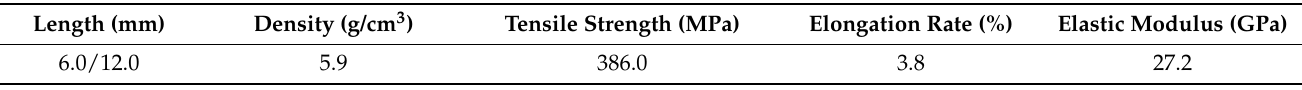
Table 1. Key characteristics of polypropylene fiber employed in the backfill.